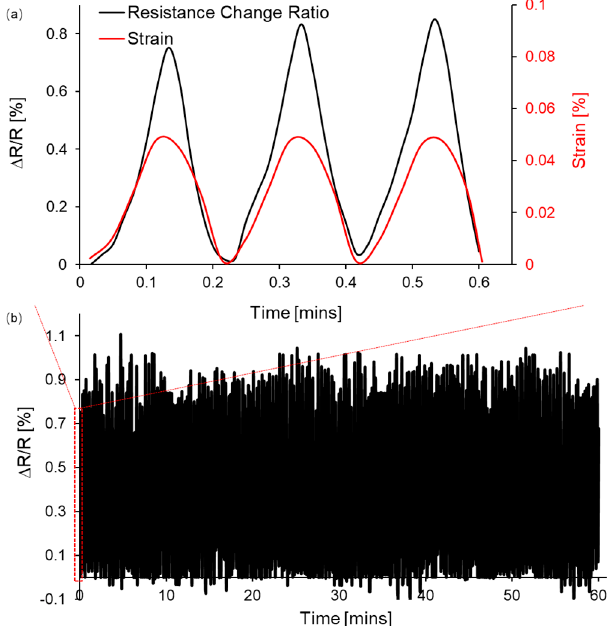
Figure 7. The normalized sensor resistance changes upon the strain in cyclic operations. ( a ) A magnified image of ( b ) 300 cycles of stretching and